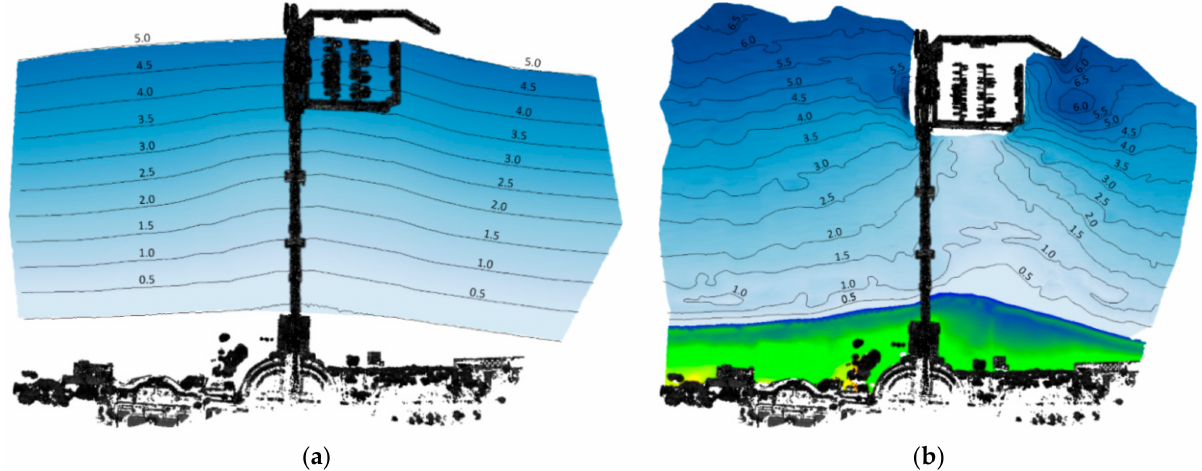
Figure 1. Bathymetric charts of the areas in the vicinity of the Sopot pier; ( a ) shows the linear interpolation of the depth performed due to the lack of actual measurement data (the data are obtained from official ENC cells), while ( b ) presents actual seabed relief resulting from bathymetric surveys carried out by the team of the Department of Geodesy and Oceanography at the GMU to a depth of approx. 0.6 m. Reprinted from ref.